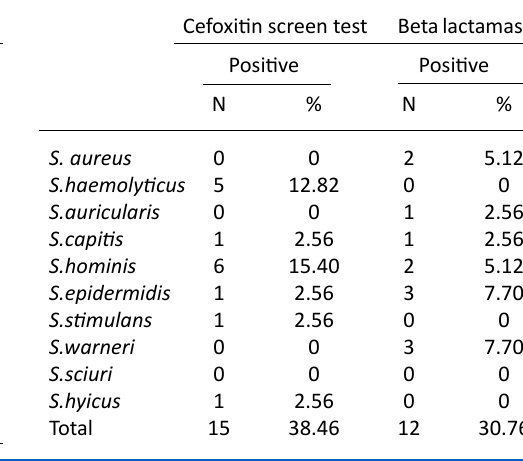
table 1. Isolated bacterial Species(N=13) and their relative abundance (%) Name of the Species N %